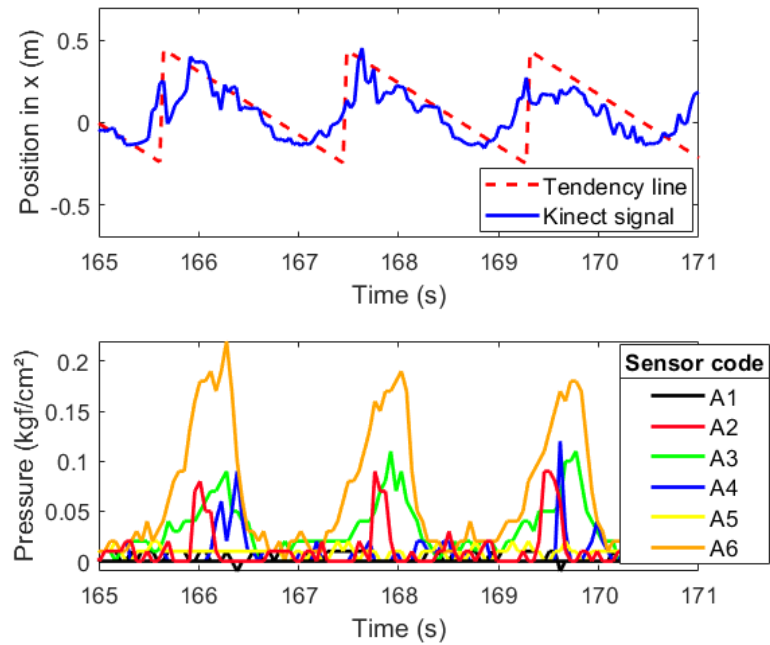
Figure 17. Pressure on the residuum and prosthetic leg trajectory for SD1.